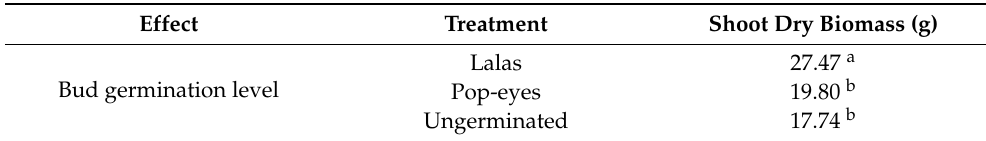
Table 6. Shoot dry biomass in response to different bud germination levels in the 2021 first greenhouse experiment a .